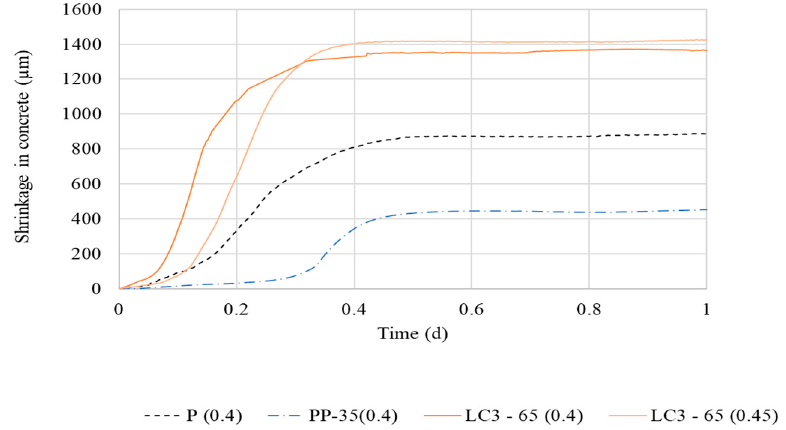
Figure 9. Impact of the water–cement ratio on volume change in concrete.